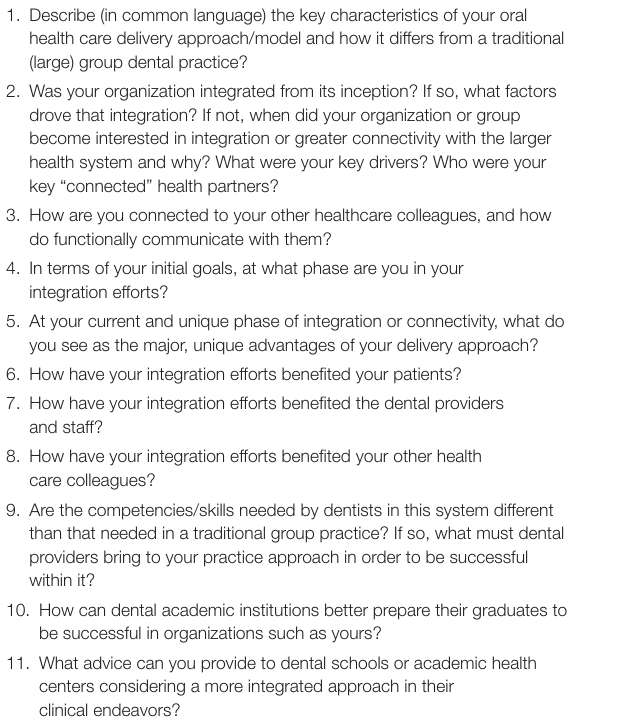
TABLE 1 | Interview guide for integrated care practice